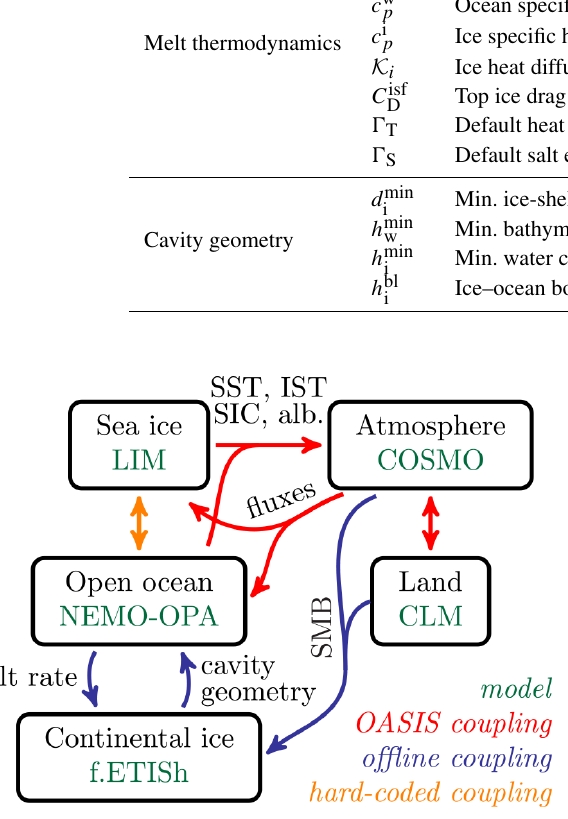
Figure 1. Fully coupled system submodel hierarchy. Each box rep- resents an Earth system component and its corresponding model. The arrow colors distinguish the different coupling methods used, with legend given in the bottom right. “SST” stands for “sea sur- face temperature”, “SIC” – “sea-ice concentration”, “IST” – “ice surface temperature”, “alb.” – “albedo” and “SMB” – “surface mass balance”. Above, “NEMO-OPA” represents the open-ocean part of NEMO (i.e., NEMO without LIM). Although they are represented, the NEMO–COSMO exchanged fields are not detailed, as they have not been changed compared to existing